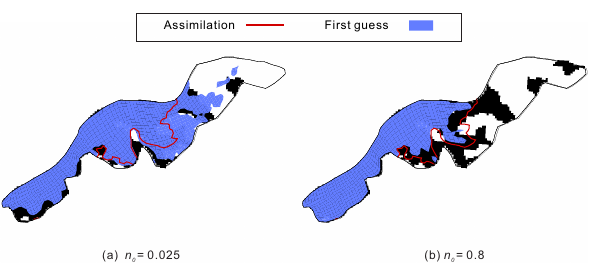
Figure 10. Comparing flood extents obtained before and after as- similation of the remotely sensed flood extent from MODIS image specified by b = 126 (background map) when (a) n 0 = 0 . 025; and (b) n 0 = 0 . 8. The solid line represents the boundary of the flood ex- tent after assimilation, where water depth is equal to h c . The filled area is the flood extent computed by forward model with n 0